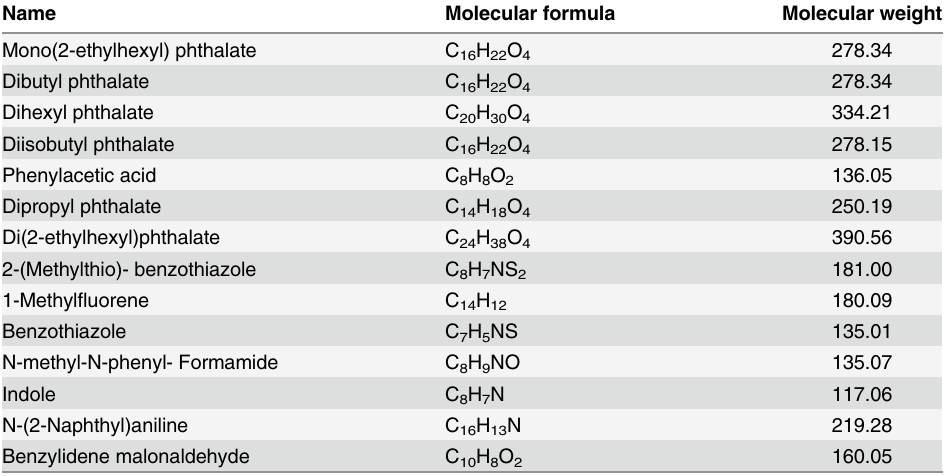
Table 1. Main organic pollutions in the irrigative wastewater taken from the Dongming discharging river in Shijiazhuang city determinated by GC-MS.